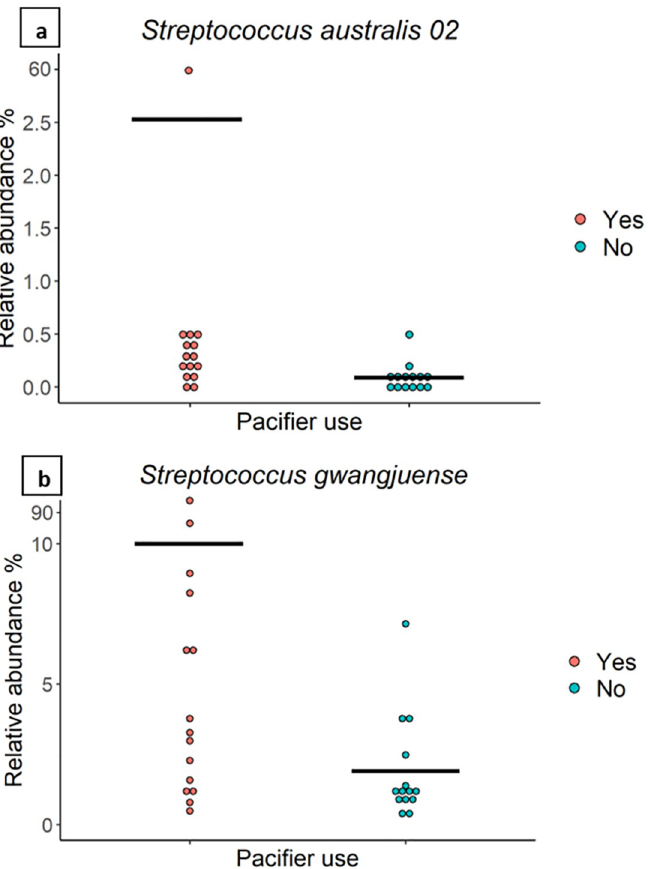
Fig 5. The relative abundance of Streptococcus spp. is associated with pacifier use. The relative abundance of bacterial taxa in milk from mothers whose infants did (n = 15) or did not (n = 14) use a pacifier. The average value for each group is indicated with a